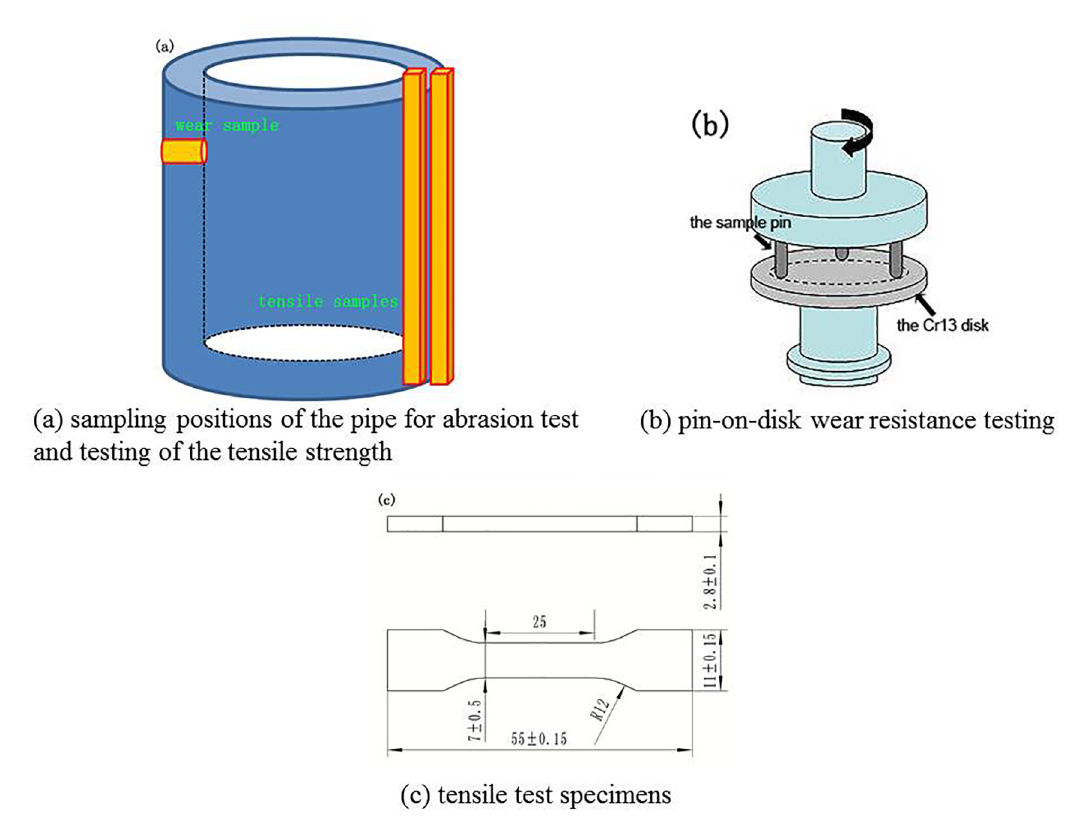
Figure 3. Mechanical testing of pipes (a) sampling positions of the pipe for abrasion test and testing of the tensile strength; (b) pin-on- disk wear resistance testing; (c) tensile test